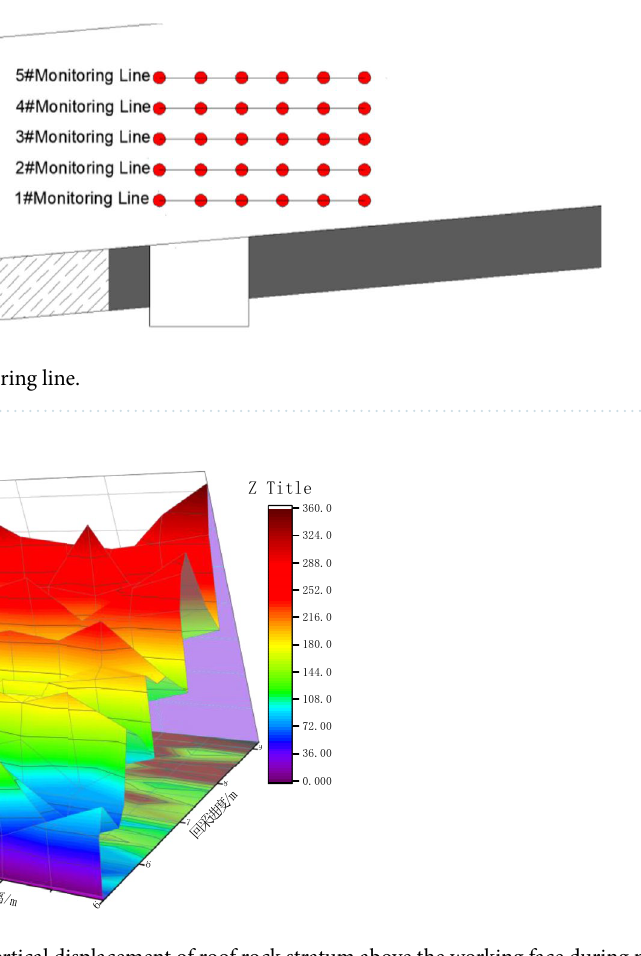
Figure 5. Change rule of vertical displacement of roof rock stratum above the working face during